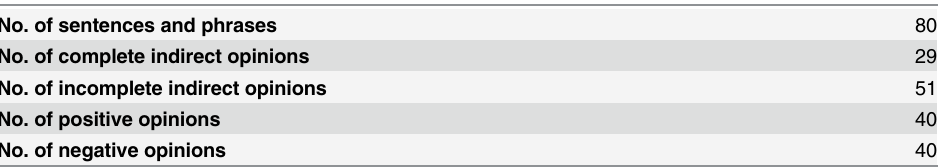
Table 11. Test set information No. of sentences and